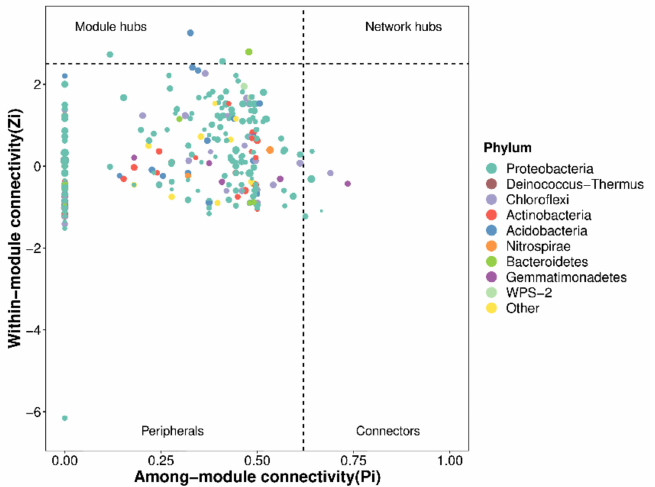
Figure 6. Scatter plots of soil bacterial marker species of Phoebe bournei seedlings under NPK fertilization treatments. The node in the network can be divided into four parts using Zi and Pi values, namely, peripherals, connectors, module hubs, and network hubs. Peripherals represent some specialists in microbial networks. Module hubs and connectors represent species that are close to generalists. Network hubs represent super-generalists among the microbial